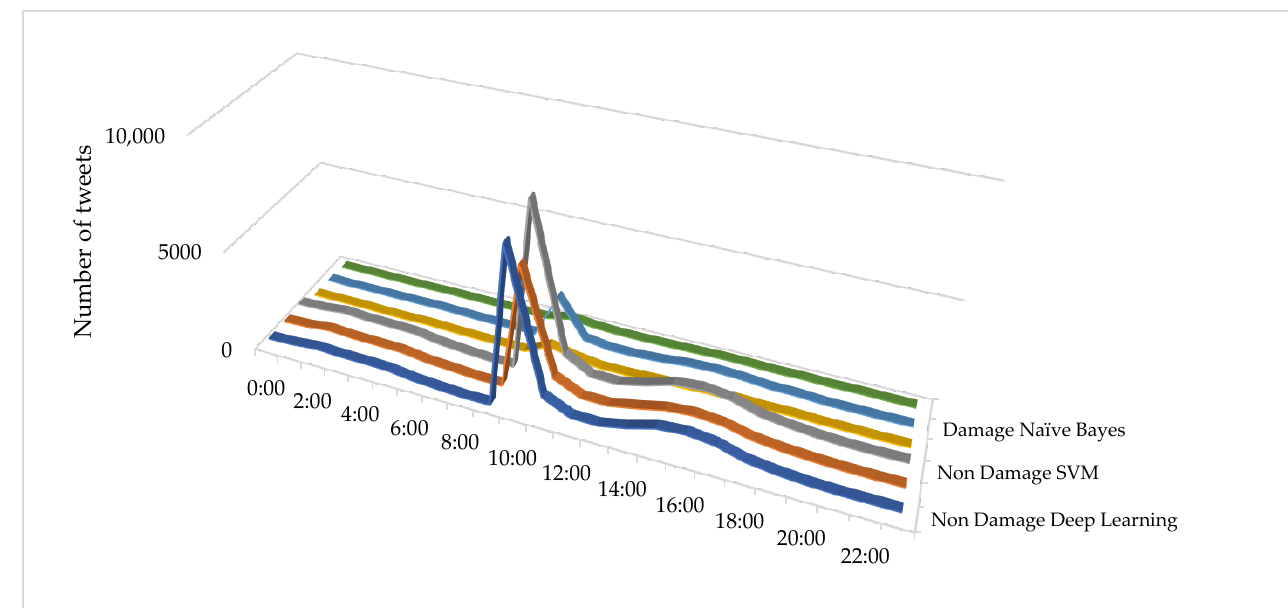
Figure 6. Number of tweets classified using the three Naive Bayes, SVM, and deep learning classification algorithms in two damage and non-damage classes in each hour on the day of earthquake.